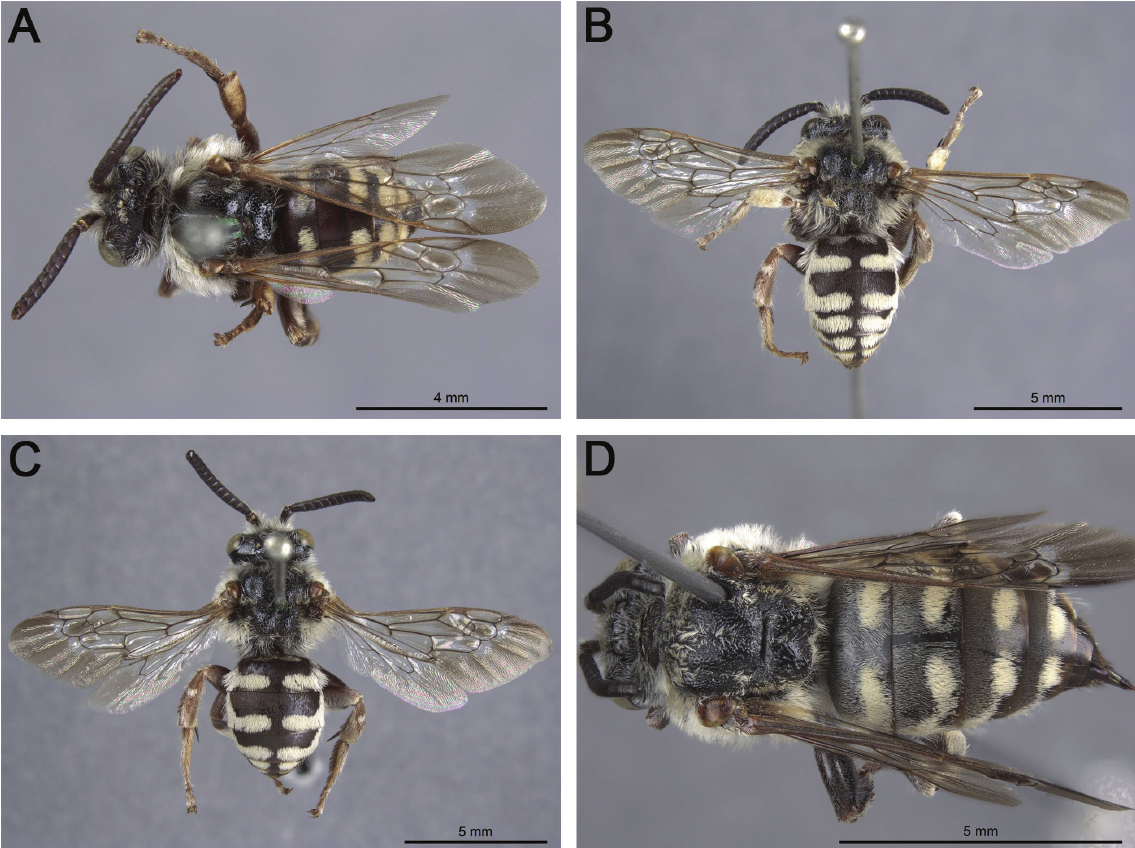
Fig. 8. Brachymelecta californica (Cresson, 1878), habitus, dorsal view. A . Male specimen (ANSP) from Nevada (bearing the same ‘Nev’ collection label as the Melecta ? mucida holotype) in which both fore wings have two submarginal cells. B . M. californica paralectotype, ♂ (ANSP 2292-7) in which the left fore wing has three submarginal cells and the right has two, with the second submarginal cross vein incomplete. C . M. californica paralectotype, ♂ (ANSP 2292-4) in which the left fore wing has two submarginal cells and the right has three (note that in both fore wings, the second submarginal cross vein (incomplete on the left, complete on the right) originates from the first submarginal cross vein, not Rs as is typical for most bees, including this species). D . Female specimen (BOLD sample ID: CCDB-34570 A03; PCYU) in which the discs of the metasomal terga are (unusually for B. californica ) covered in short, pale hairs, sparser than those comprising the apical